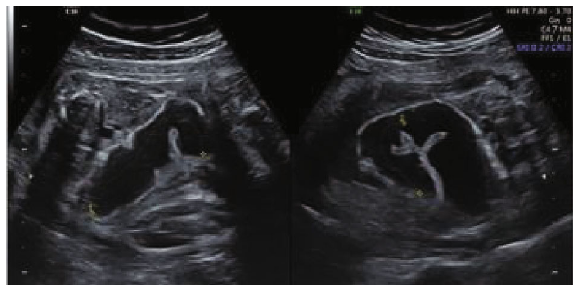
Figure 2: An important segmental intestinal dilatation at 32 weeks.